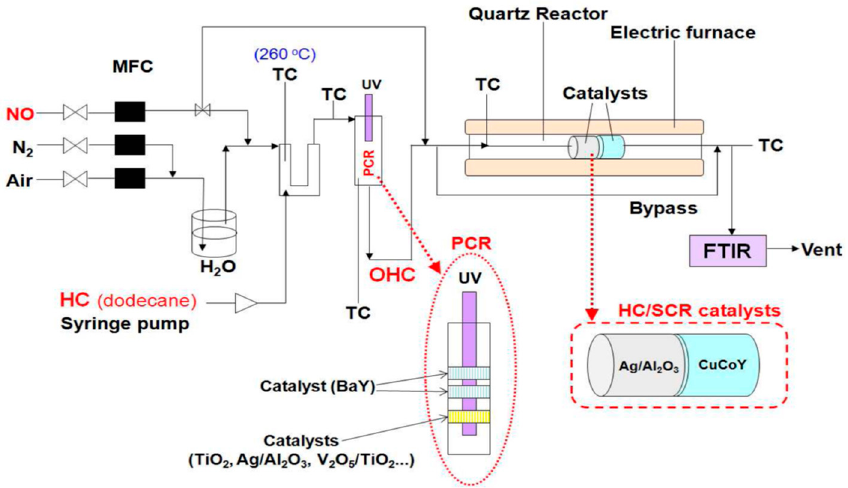
Figure 27. Schematic flow diagram of the hybrid PCR + HC/SCR reactor system. Reproduced with permission from Heo et al. [114]. Copyright 2013 by the American Chemical Society. Table 5. Effect of catalysts on the performance of the PCR system at 150 °C. Feed gas composition: